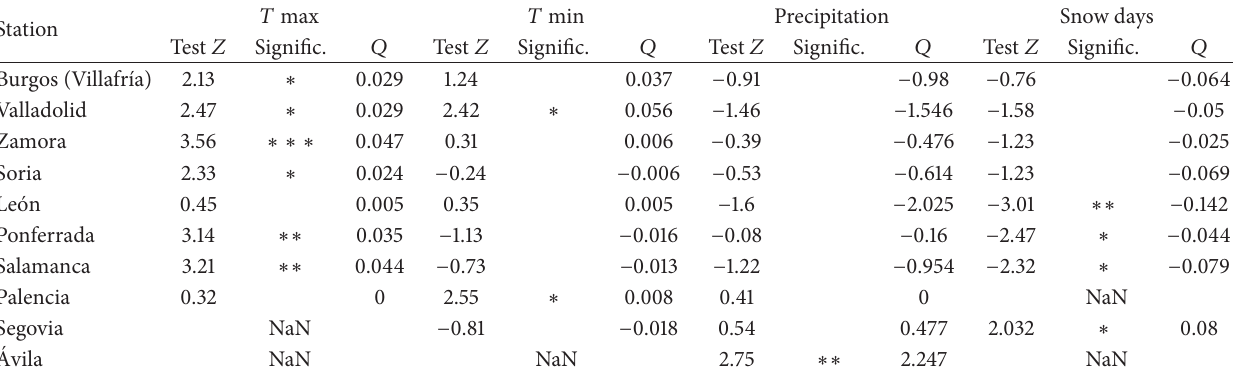
Palencia 0.32 0 Segovia NaN − 0.81 − 0.018 0.54 0.477 2.032 ´Avila NaN NaN